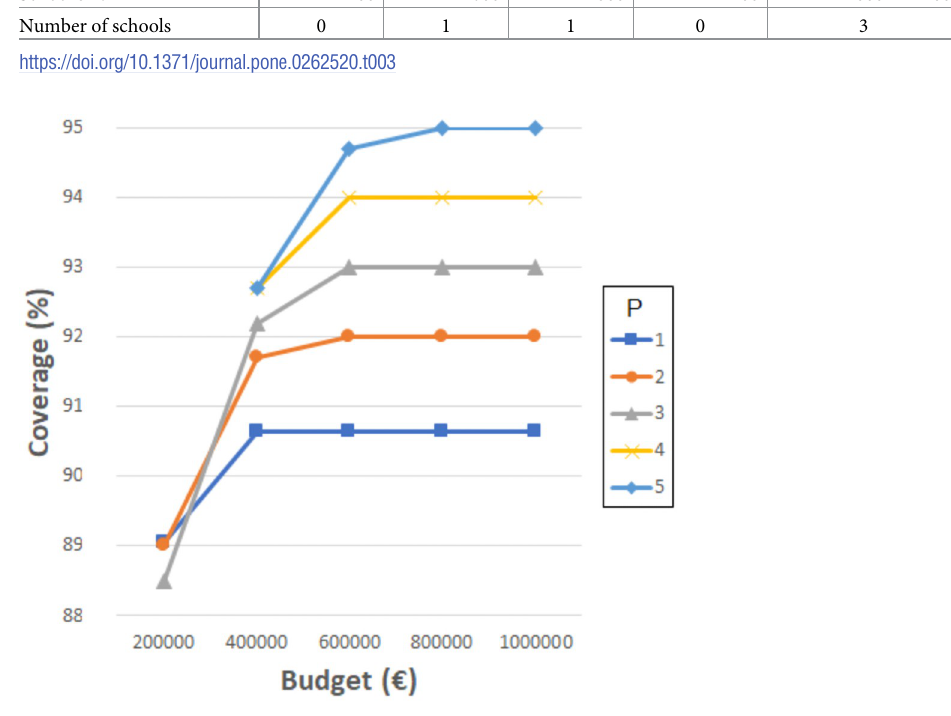
Fig 14. Coverage in 2020-2025 with new